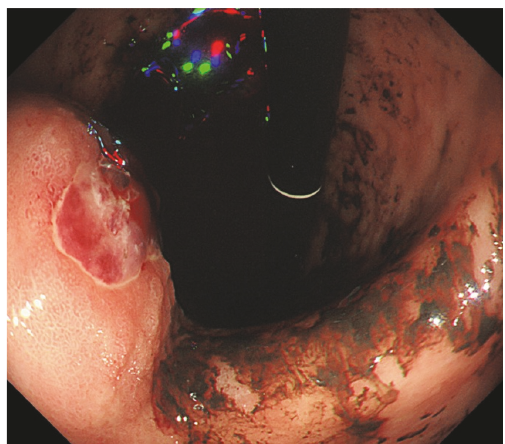
Figure 3: Emergent upper gastrointestinal endoscopy showed a submucosal tumor with central ulceration located on the anterior wall of the gastric body, corresponding to extraluminal compression by the hepatocellular carcinoma.